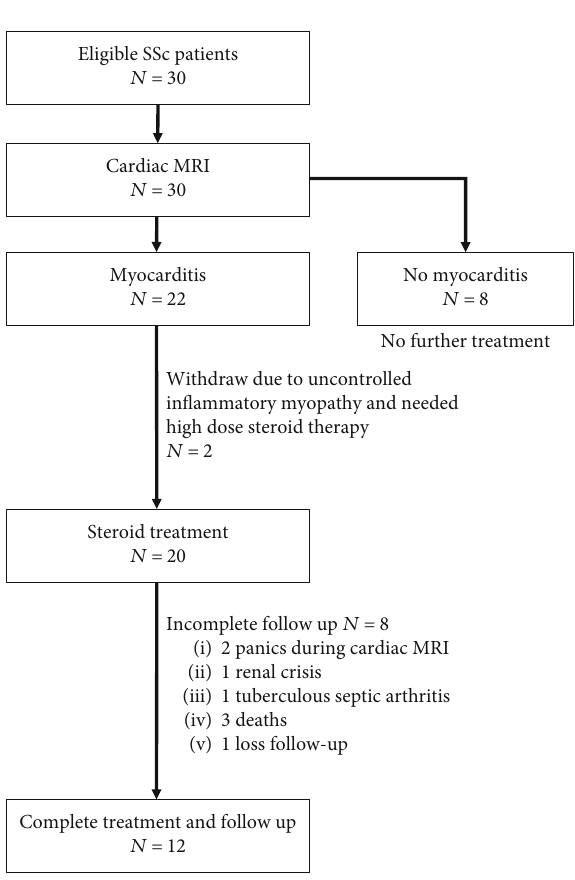
Figure 1: Flow diagram of the